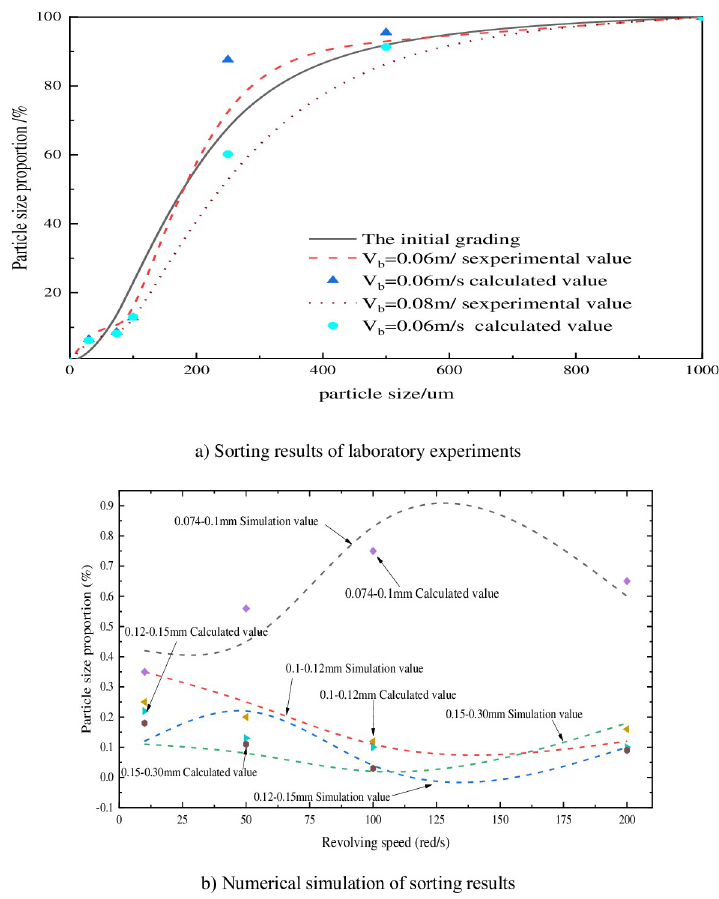
Fig 5. Comparison of separation rules of surface sediments under different disturbance velocities. a) Sorting results of laboratory experiments, b) Numerical simulation of sorting results.